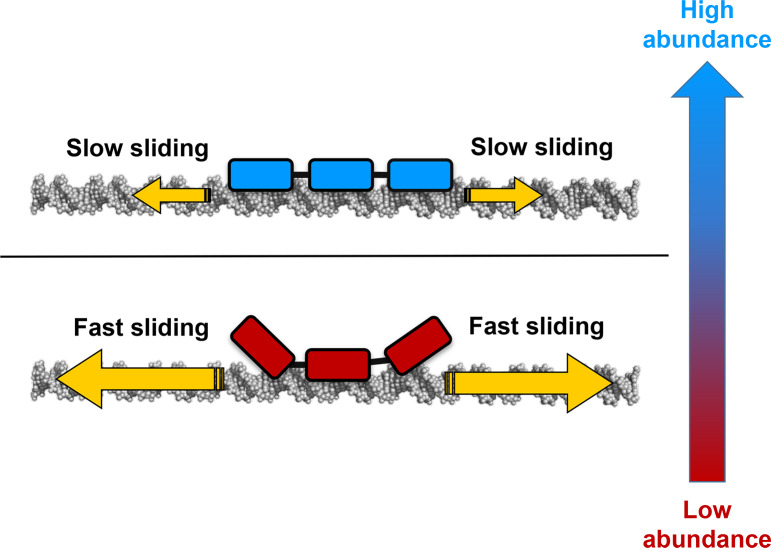
A schematic illustration on the linkage between asymmetry and abundance and its consequence on recognition kinetics.The finding that zinc finger proteins with greater non-specific asymmetry are less abundant than protein with lower non-specific asymmetry can be linked to their kinetic of DNA recognition. Proteins with lower asymmetry are expected to diffuse more slowly on DNA, which can be compensated by their higher abundance that increases the probability of fruitful target site recognition. Proteins with greater asymmetry diffuse faster and therefore may search the DNA efficiently even when their abundance is low.